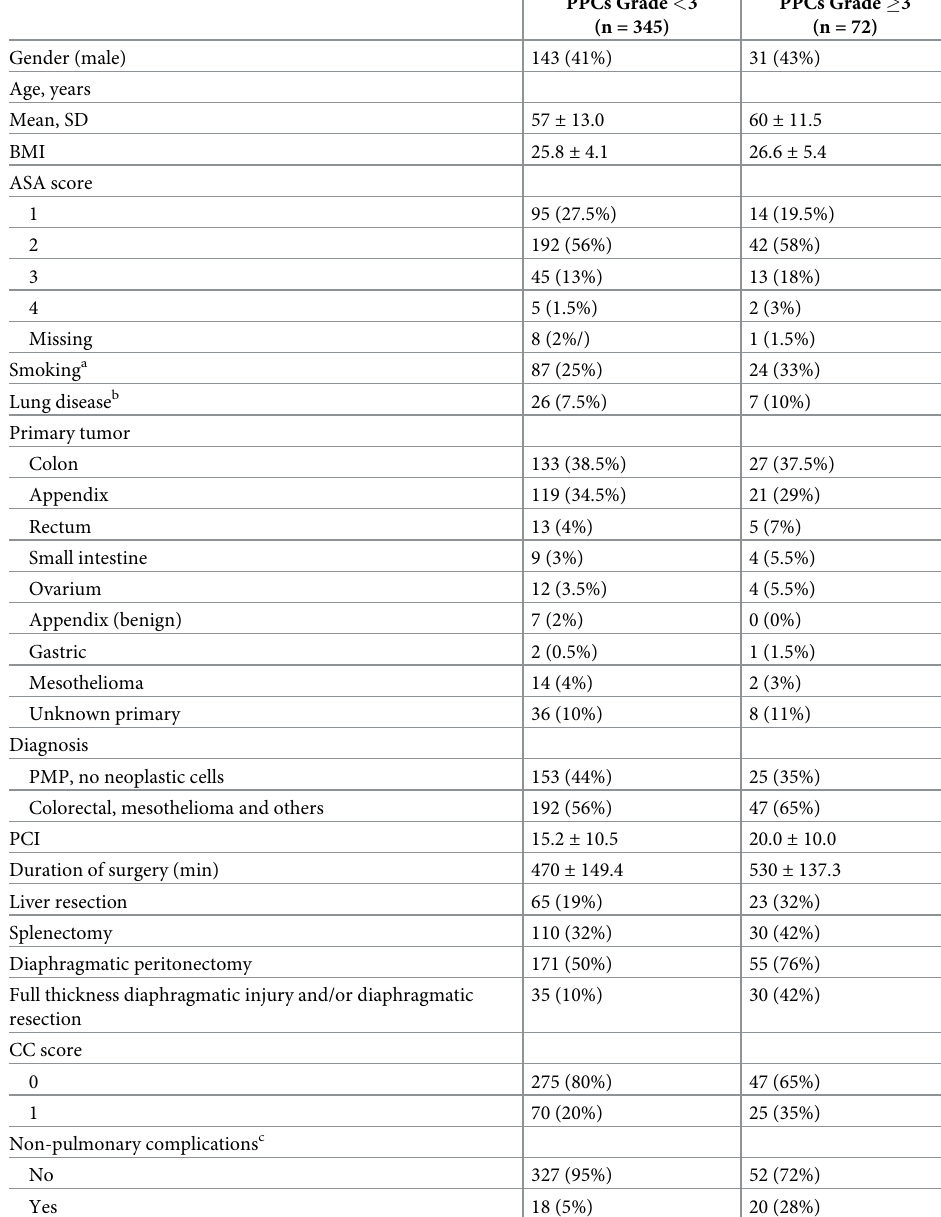
Table 1. Characteristics of 417 patients undergoing CRS and HIPEC between 2007 and